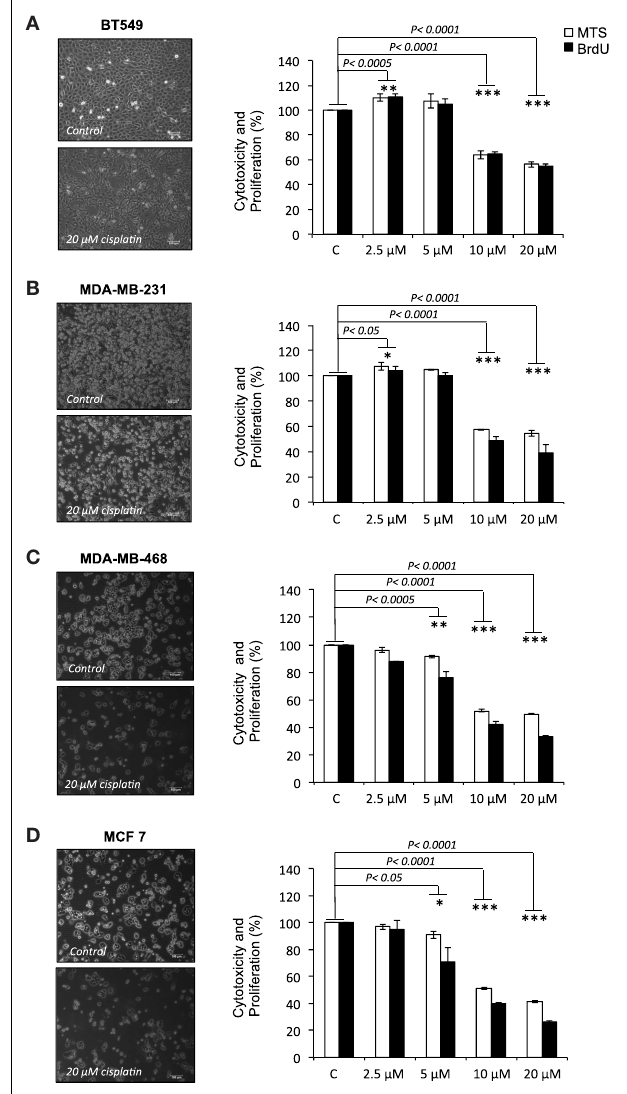
FIGURE 1 | Cisplatin reduces cell viability and proliferation in breast cancer cells . (A) BT-549, (B) MDA-MB-231, (C) MDA-MD-468, and (D) MCF-7 breast cancer cells cultured without or with 20 µ M cisplatin for 24h. The bar charts show the effect of cisplatin at increasing concentrations (2.5, 5, 10, and 20 µ M) on cell viability and proliferation in the BT-549, MDA-MB-231, MDA-MD-468, and MCF-7 respectively, which were determined by MTS (white bars) and BrdU (black bars) assays. Experiments were done in quadruplicate in three independent experiments. Bars are presented as mean ± SD ( n = 3). * p ≤ 0.05; ** p ≤ 0.0005; *** p ≤